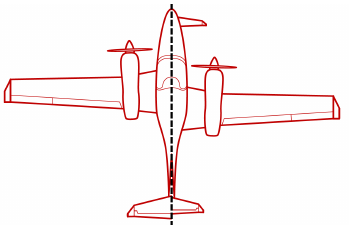
Figure 9. Comparison of the original planform of the DA-42 and the modified three-surface